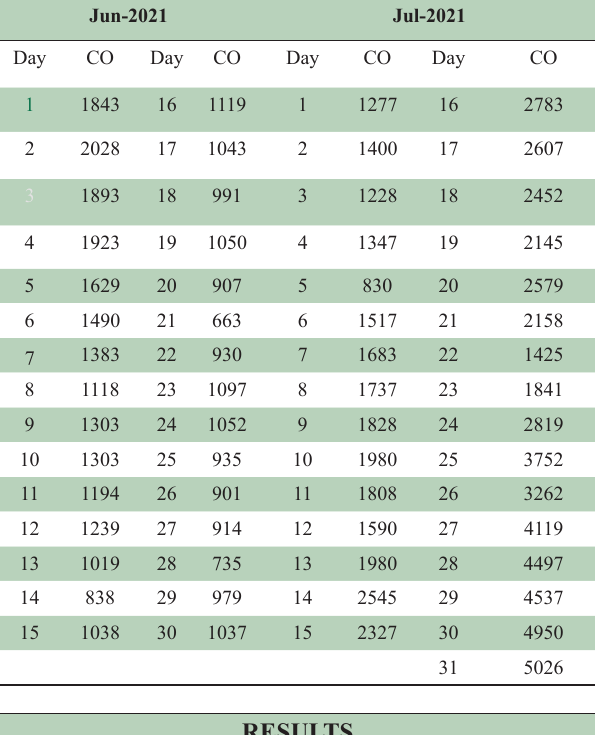
Table-I: COVID-19 confirmed outbreaks (CO) in Pakistan.